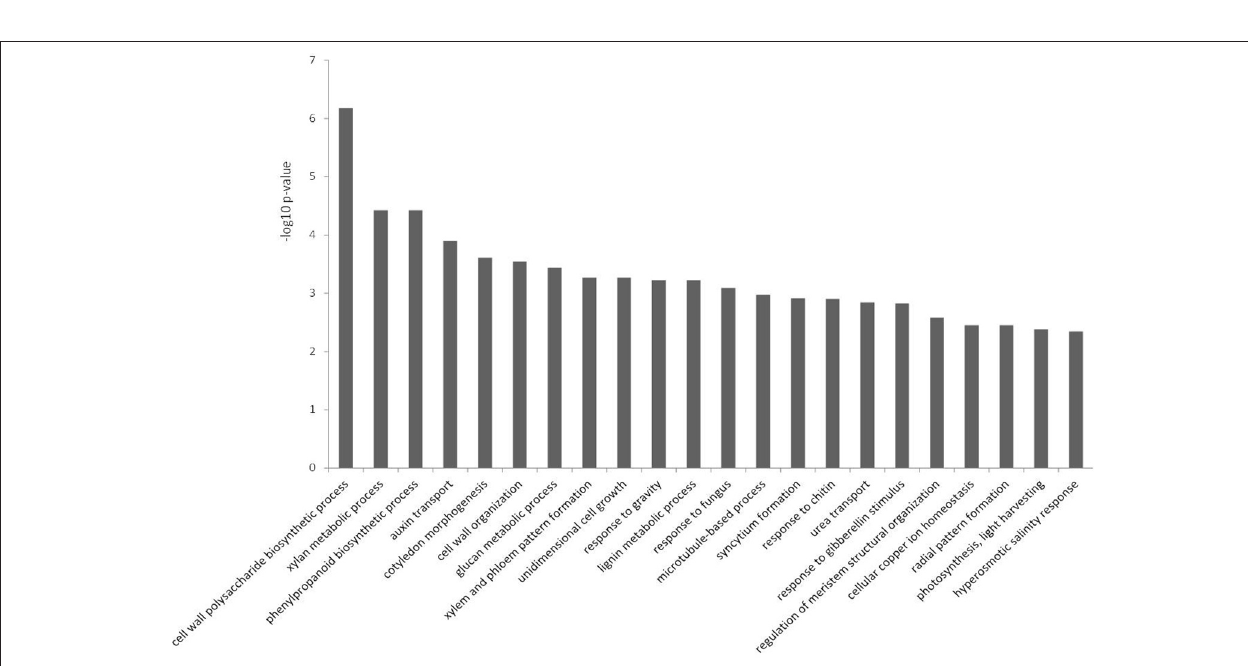
sojae (Sugano et al., 2013) and it has been proposed that et al., 2014b), where Arabidopsis auxin sensitivity and transport mutants were shown to be highly susceptible to the